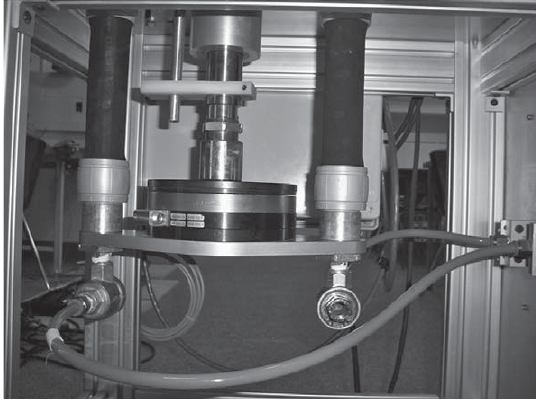
Fig. 2. The compression apparatus of the mastication mechanism. Two fluidic muscles are on either side of a pneumatic piston. The piston passes through a bushing at the bottom of the basin. Attached below the piston is a 6 degree load cell.